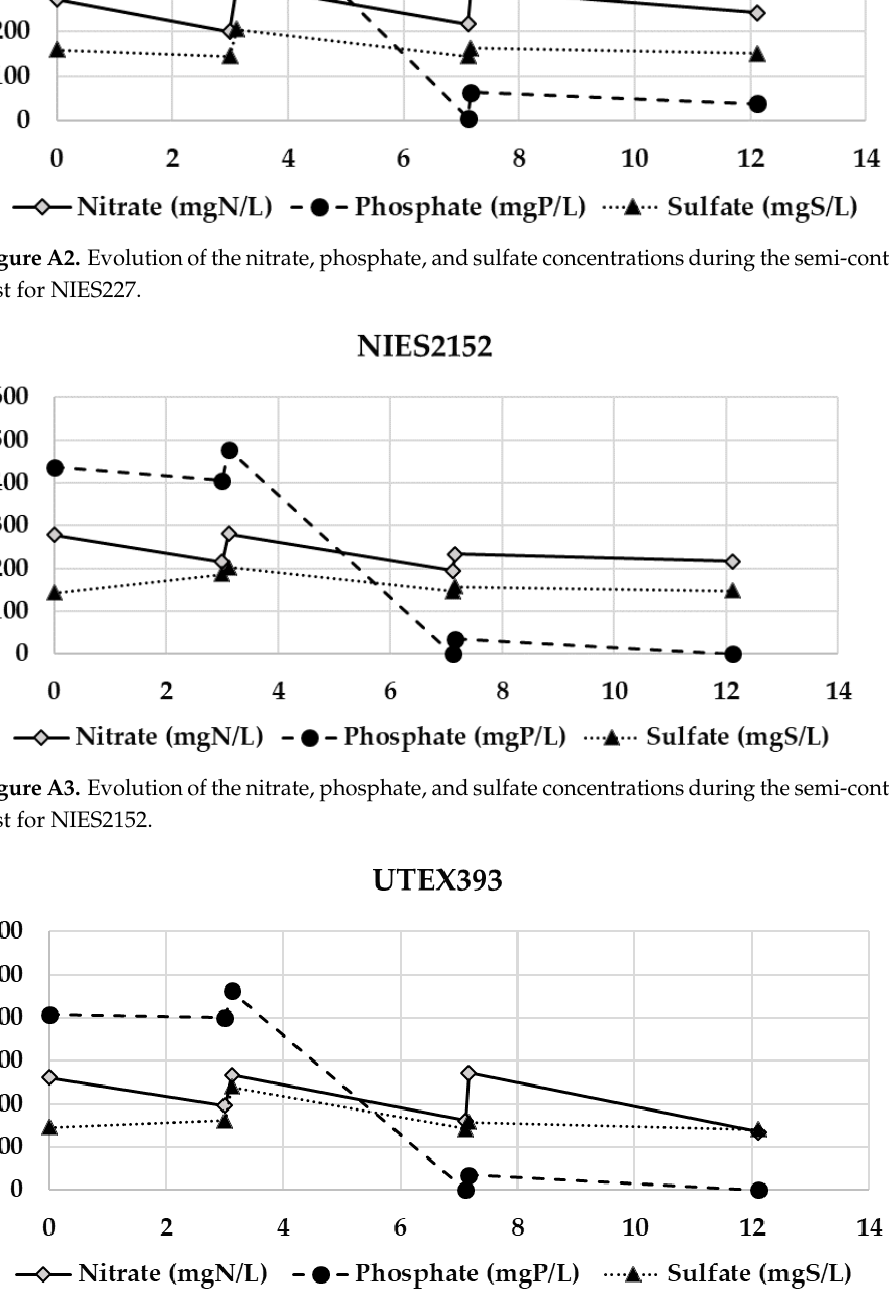
Figure A5. Evolution of the nitrate, phosphate, and sulfate concentrations during the semi-contin- uous test for UTEXB614. Figure A6. Evolution of the nitrate, phosphate, and sulfate concentrations during the semi-contin- uous test for consortium B1.